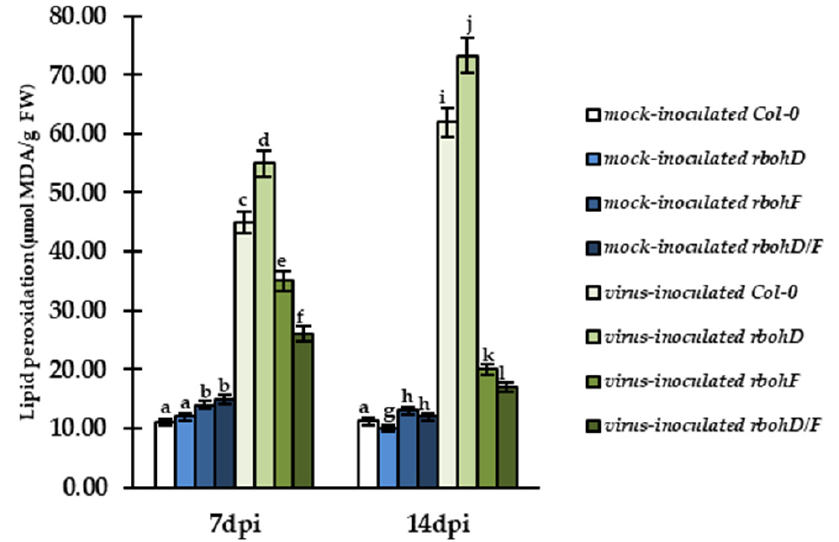
Figure 11. Validation of lipid peroxidation based on the amount of MDA in the leaves of TuMV- and mock-inoculated Col-0, rbohD , rbohF , and rbohD/F plants between 7 and 14 dpi. The mean amount of MDA ( µ mol MDA/g FW) was calculated and analyzed by ANOVA and Tukey’s HSD test at p < 0.05. Statistically significant values are indicated by letters above the